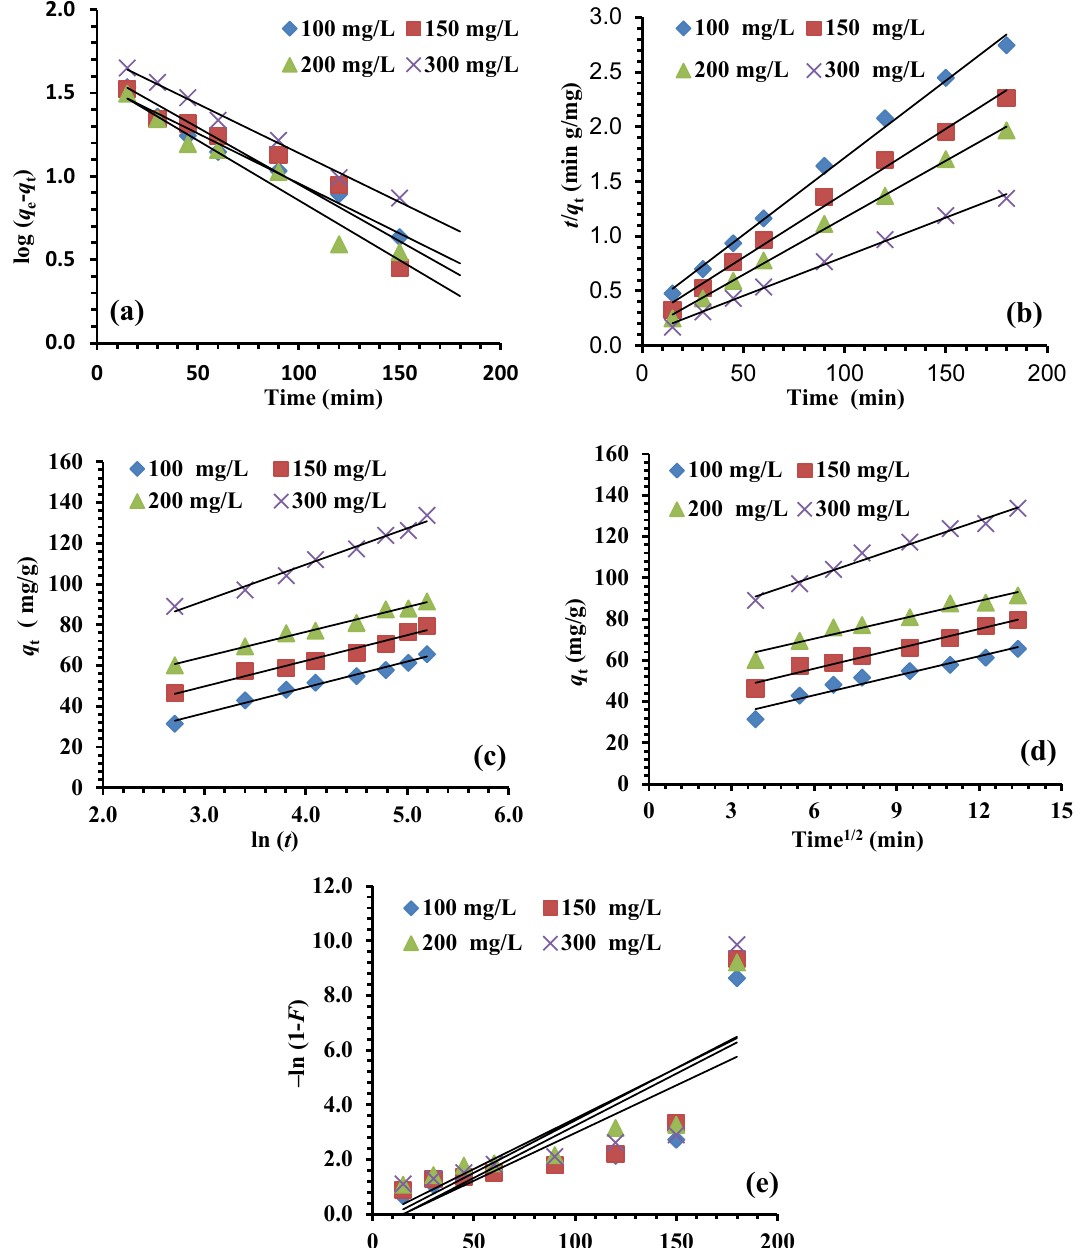
Figure 11. Kinetic adsorption analysis ( a ) PFOM; ( b ) PSOM, ( c ) EM, ( d ) IPDM, and ( e )